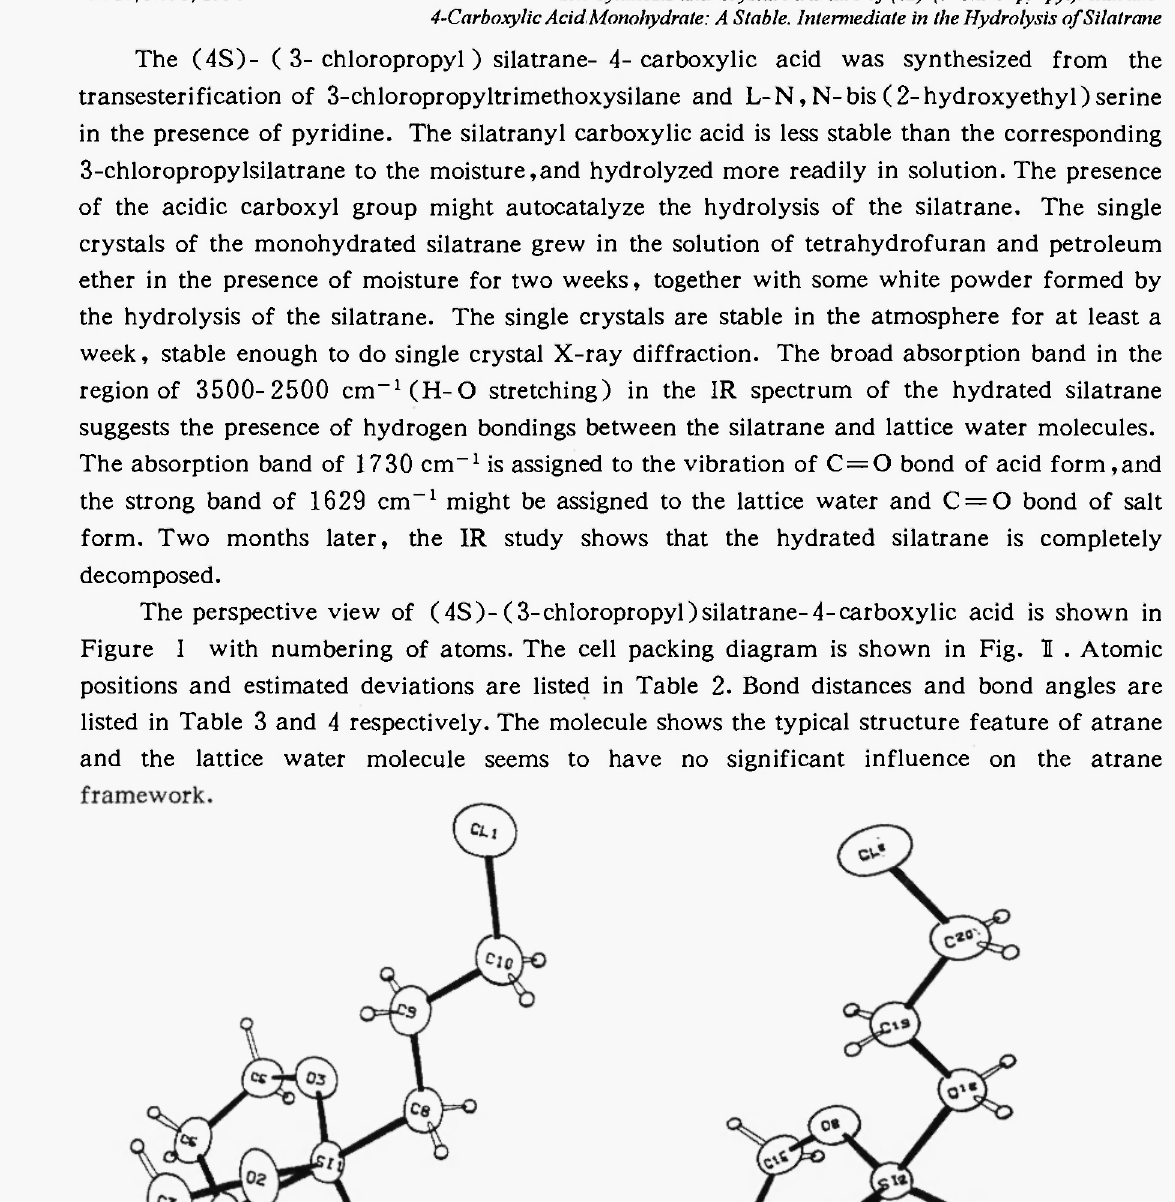
Figure I .The perspective view of (4S)-1-(3-chloropropyl)silatrane-4-carboxylic acid .